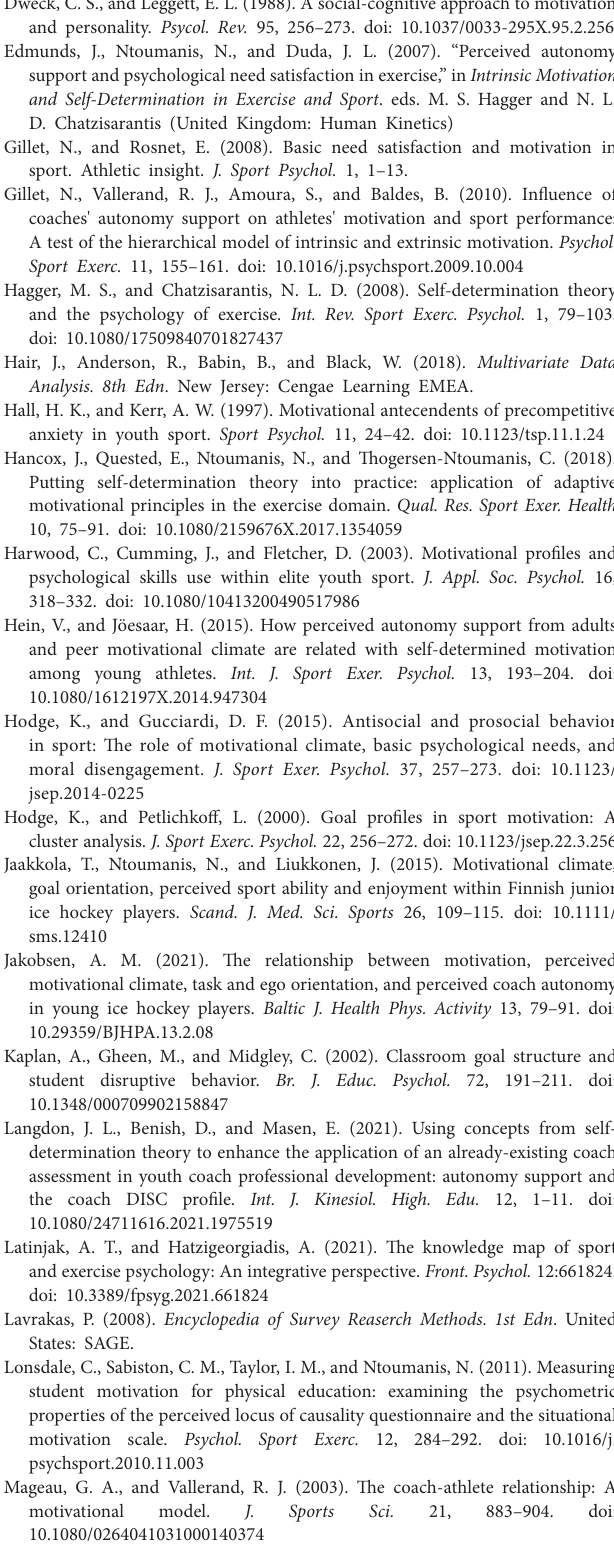
figure skaters. J. Sport Exerc. Psychol. 24, 376–395. doi: 10.1123/jsep.23.4.376 Dweck, C. S., and Leggett, E. L. (1988). A social-cognitive approach to